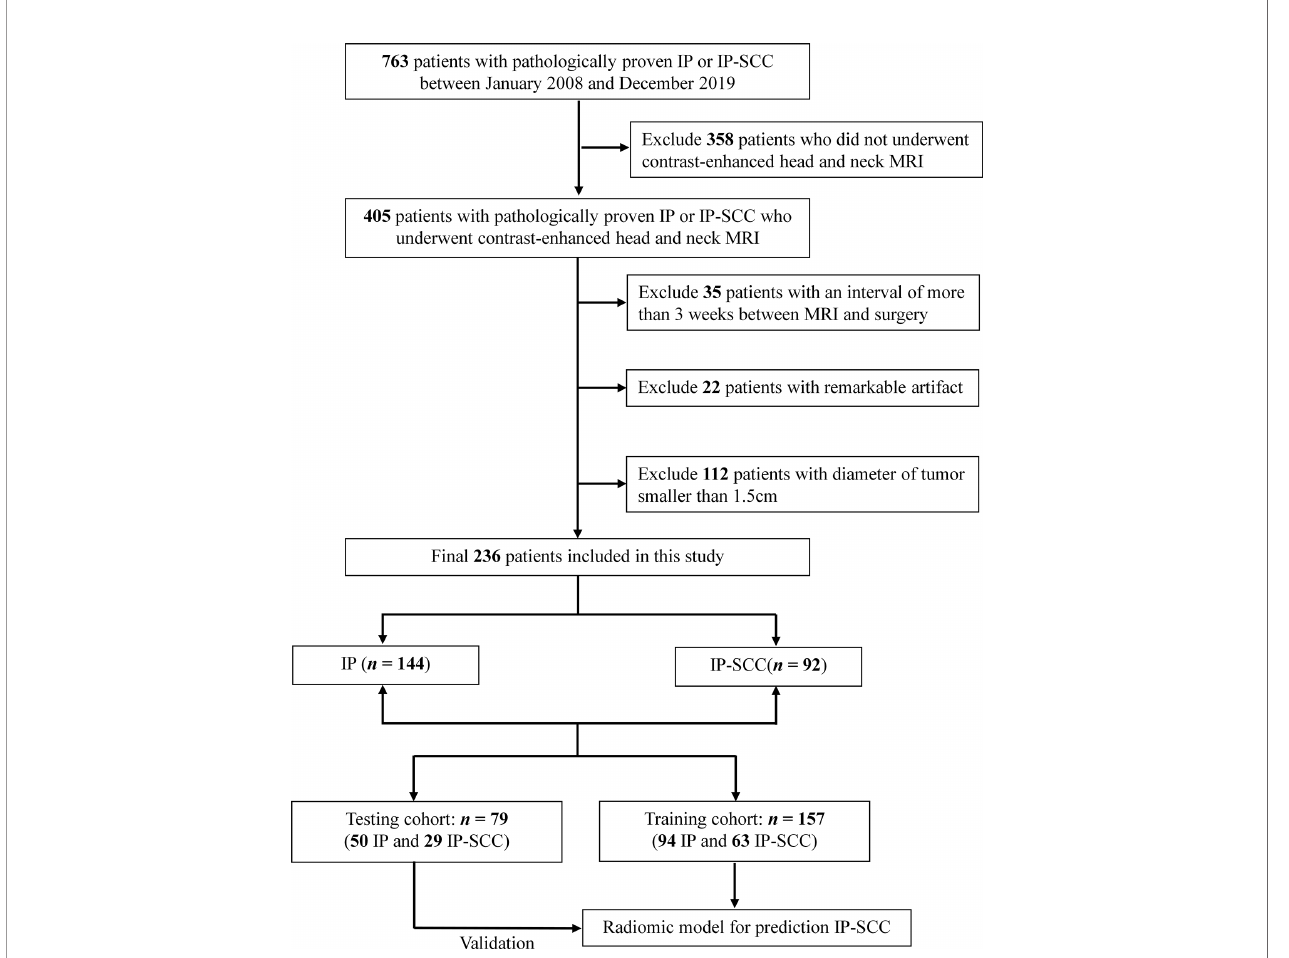
FIGURE 1 | Flow diagram shows the procedure of data selection for prediction of malignant transformation of inverted papilloma. IP, inverted papilloma; IP-SCC, inverted papilloma – transformed squamous cell